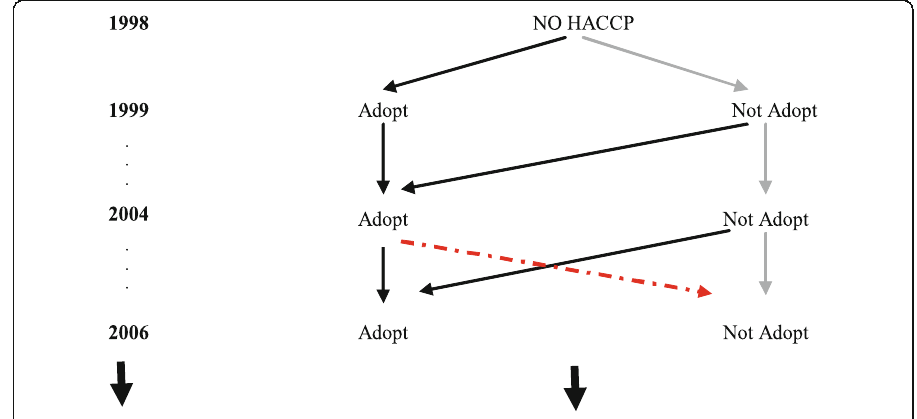
Fig. 2 Observed outcome of firms ’ decision on HACCP adoption over